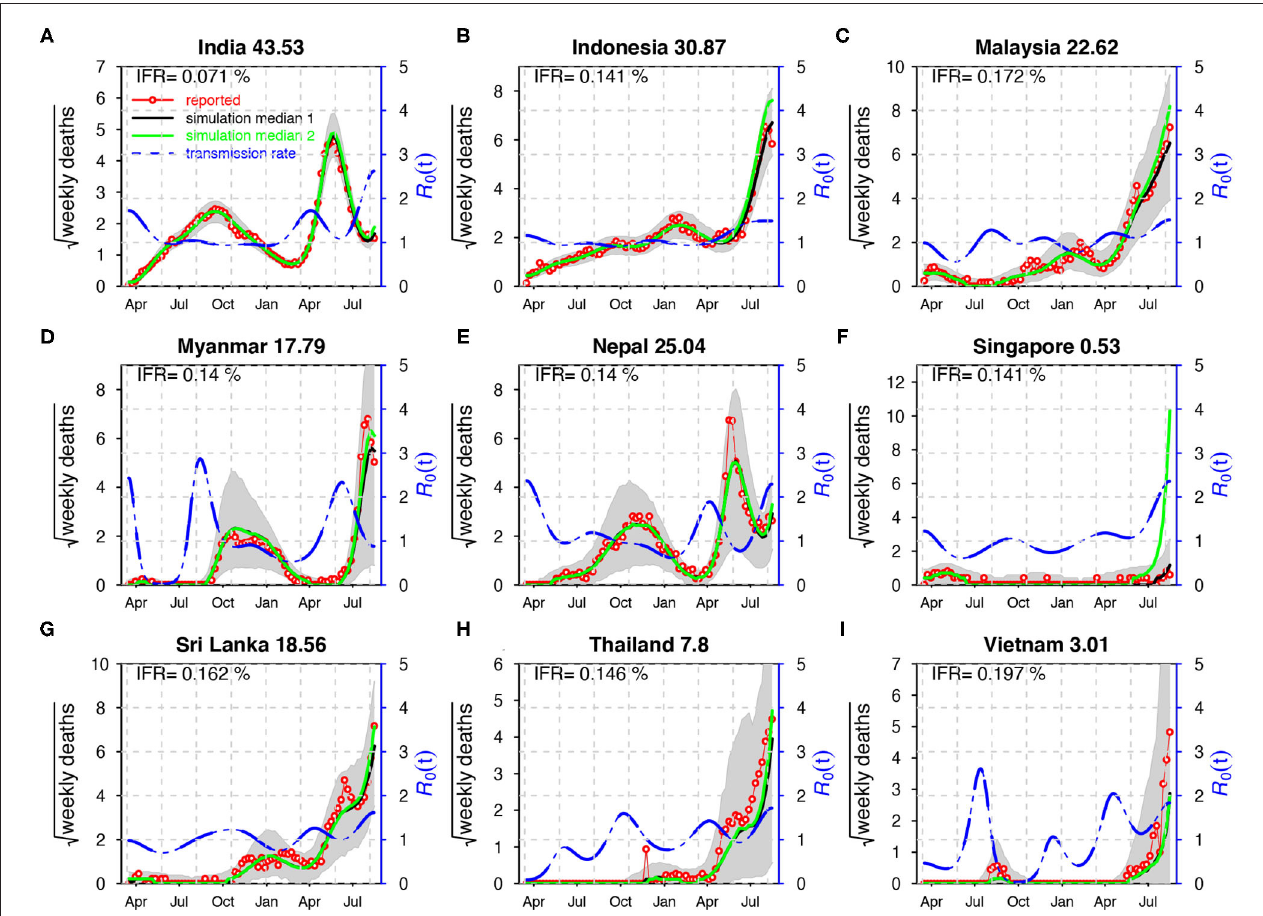
FIGURE 3 | Fitting the model to the reported deaths in India (A) , Indonesia (B) , Malaysia (C) , Myanmar (D) , Nepal (E) , Singapore (F) , Sri Lanka (G) , Thailand (H) , and Viet Nam (I) with a time-varying transmission rate. The red circles denote the daily reported COVID-19 deaths. The black curve denotes the median of 1,000 model simulations with vaccination, while the green curve shows the simulation median without vaccination. The shaded region denotes the 95% CI of the 1,000 model simulations. The blue-dashed curve denotes the reconstructed transmission rate. φ = 0.008 for India; φ = 0.03 for other countries. Here, R 0 = β ( t ) /γ . The IFR is shown in each panel and the IAR is shown above each